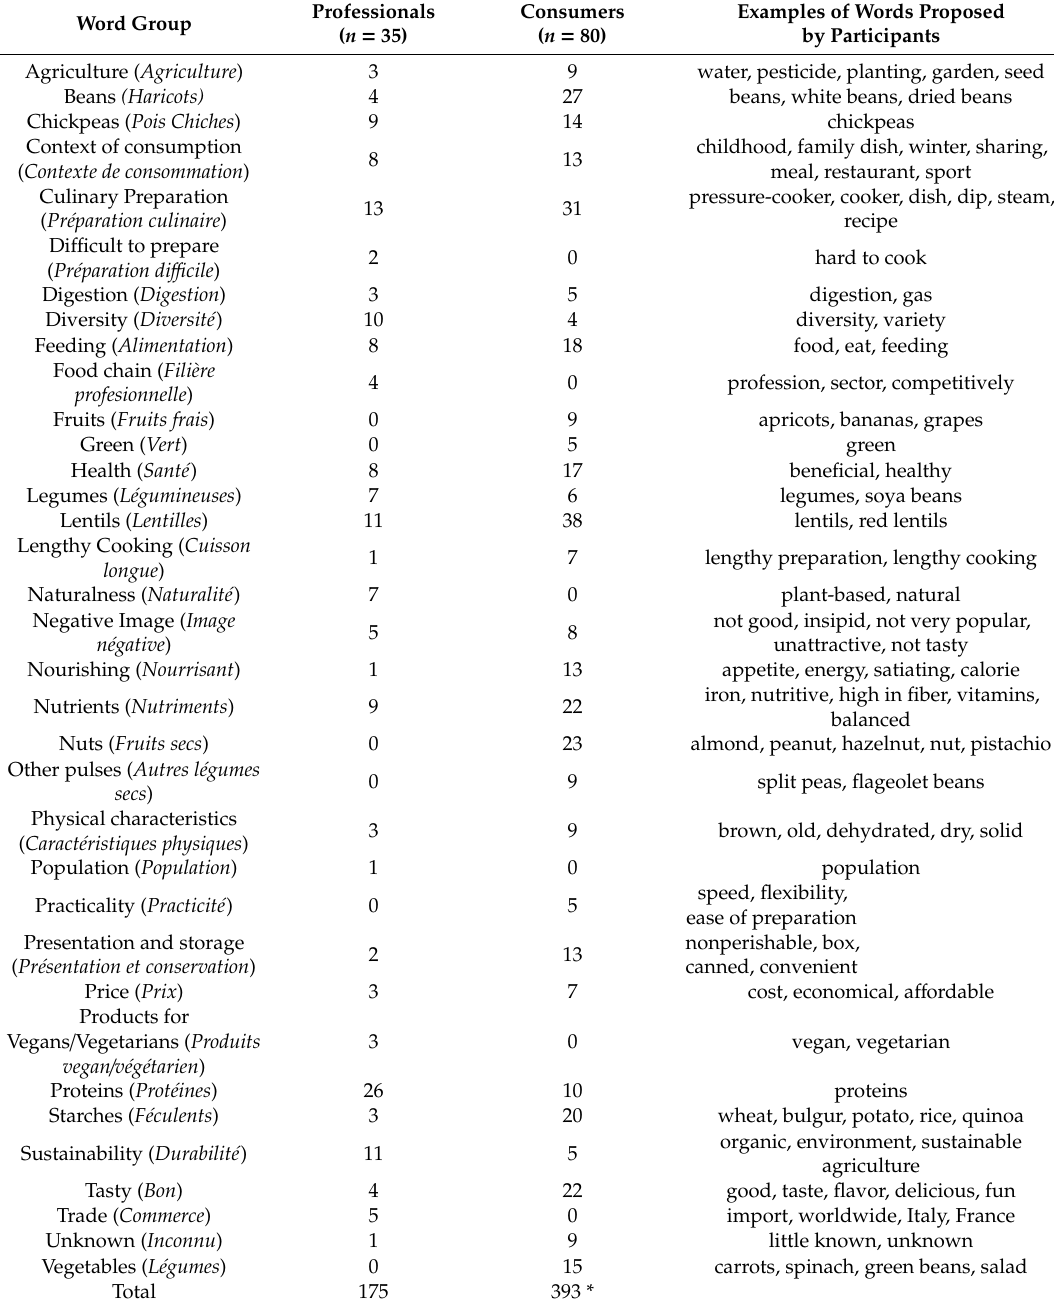
Table 1. Frequency of use for each word group, for professionals and for consumers, with examples of words evoked for “pulses”. Italics for the word group name in